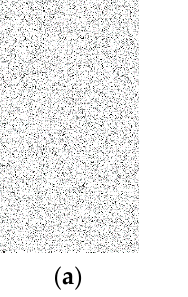
Figure 6. Rate is 0.15, ( a ) is the completely random cases; ( b ) is DUD scenarios; ( c ) is DAD scenarios and ( d ) is CAD scenarios, and all images look very similar to each other.